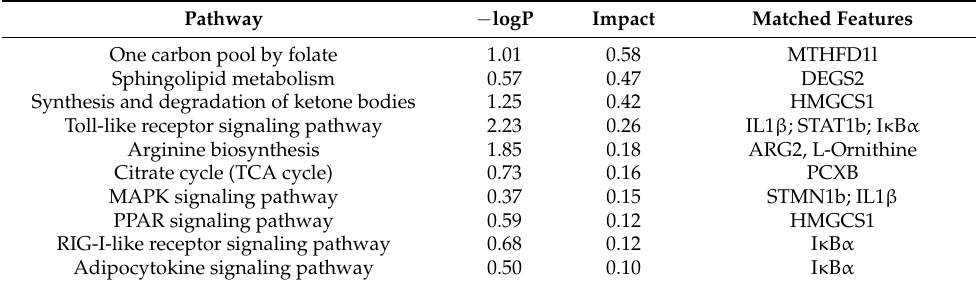
Table 1. Matched features in KEGG pathways